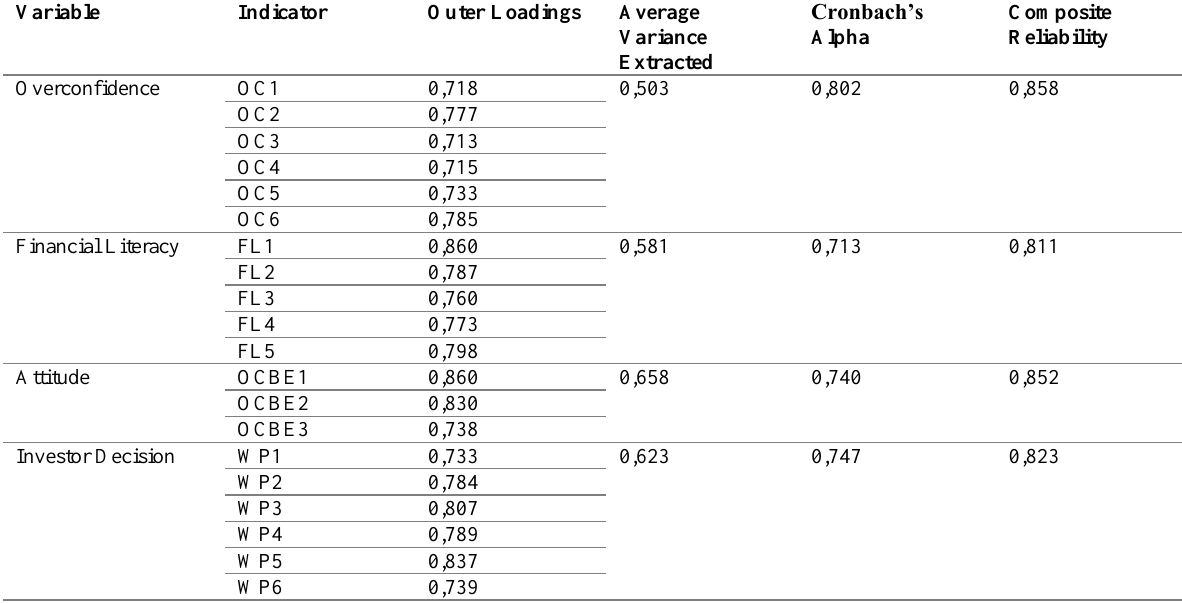
Table 2: Validity and Reliability of Indicators